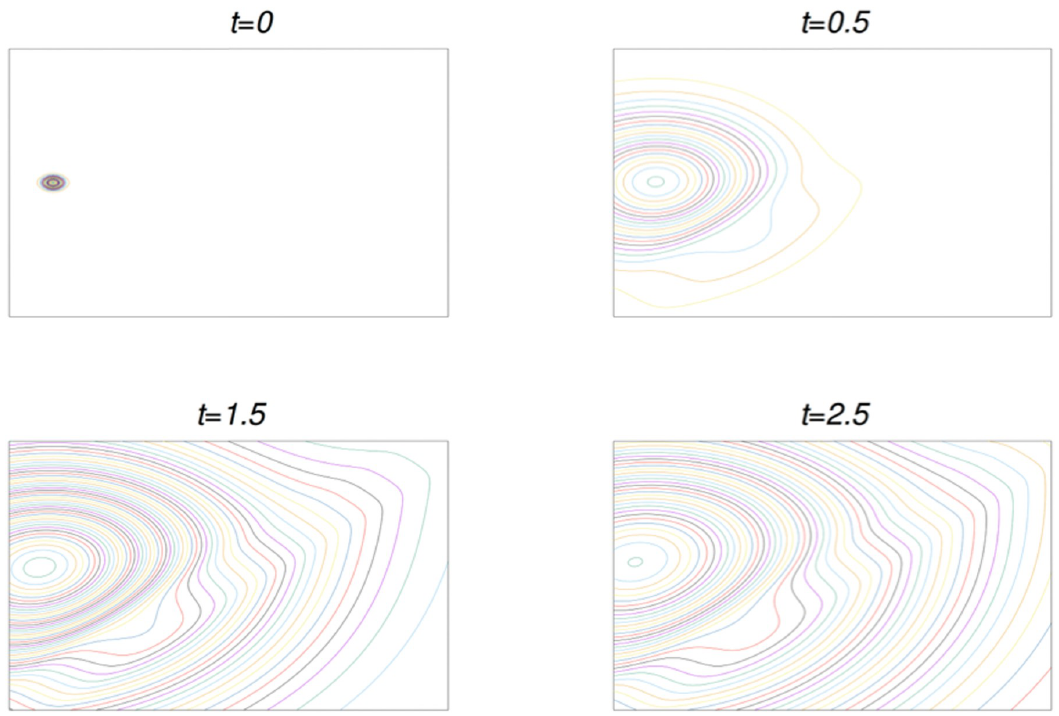
Fig 3. Snapshot for the isocontours of u at different times, for the case D 2 = 0.95, ρ 0 = − 0.25. In this example the outbreak is centered at x 5 ; 1 . The domain of the plots is A src